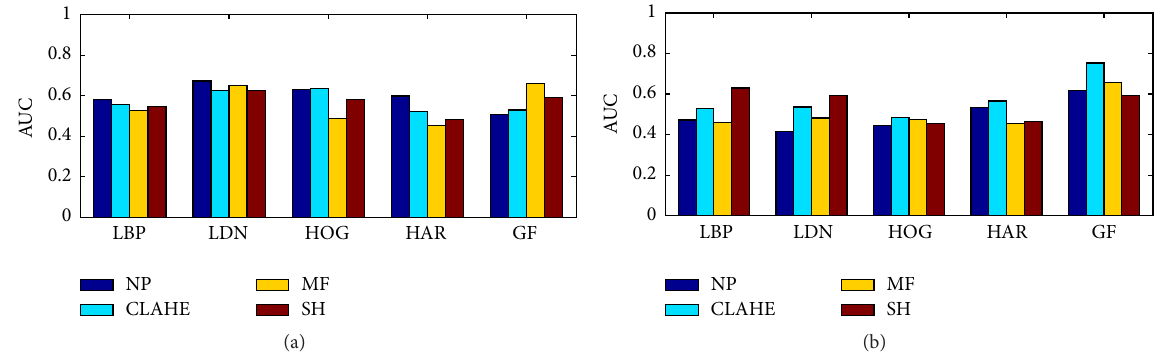
Figure 4: The performance of the texture analysis methods with NP, CLAHE, MF, and SH using (a) the LSVM and (b) the NLSVM.